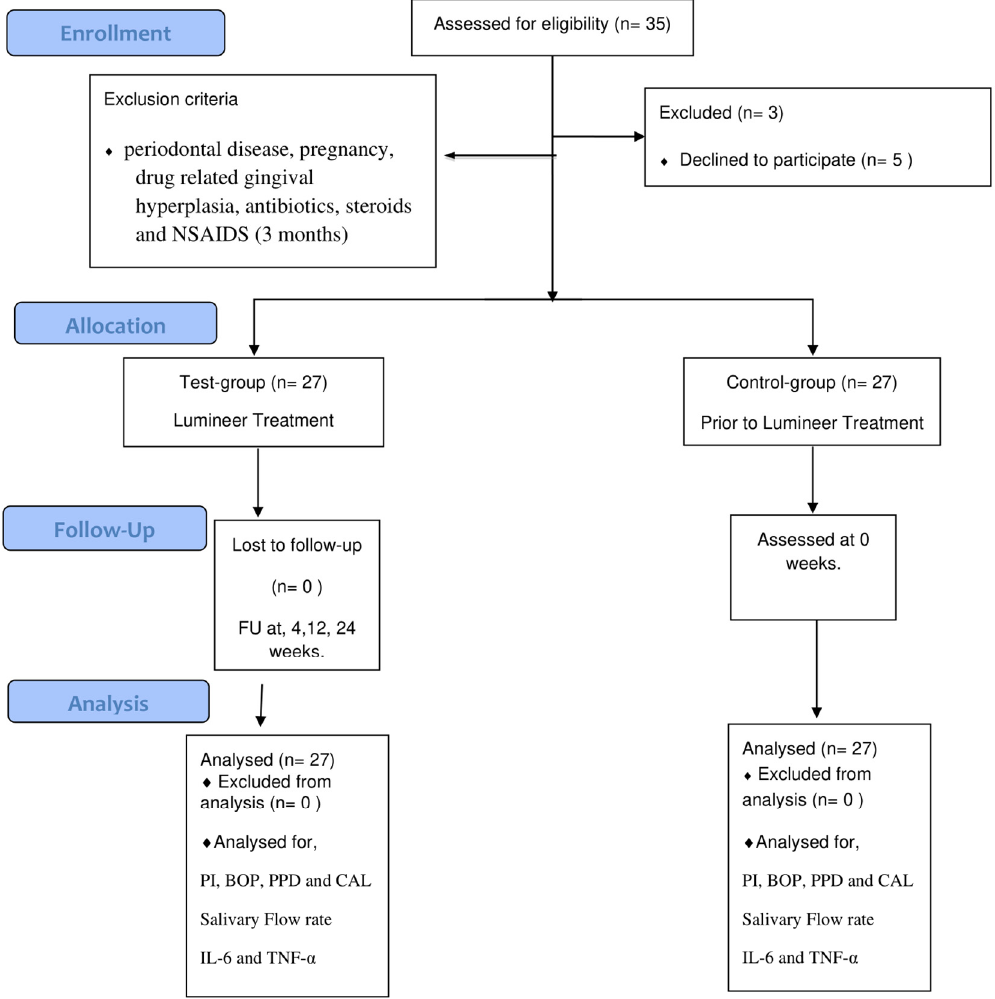
Figure 1. Flow diagram for study